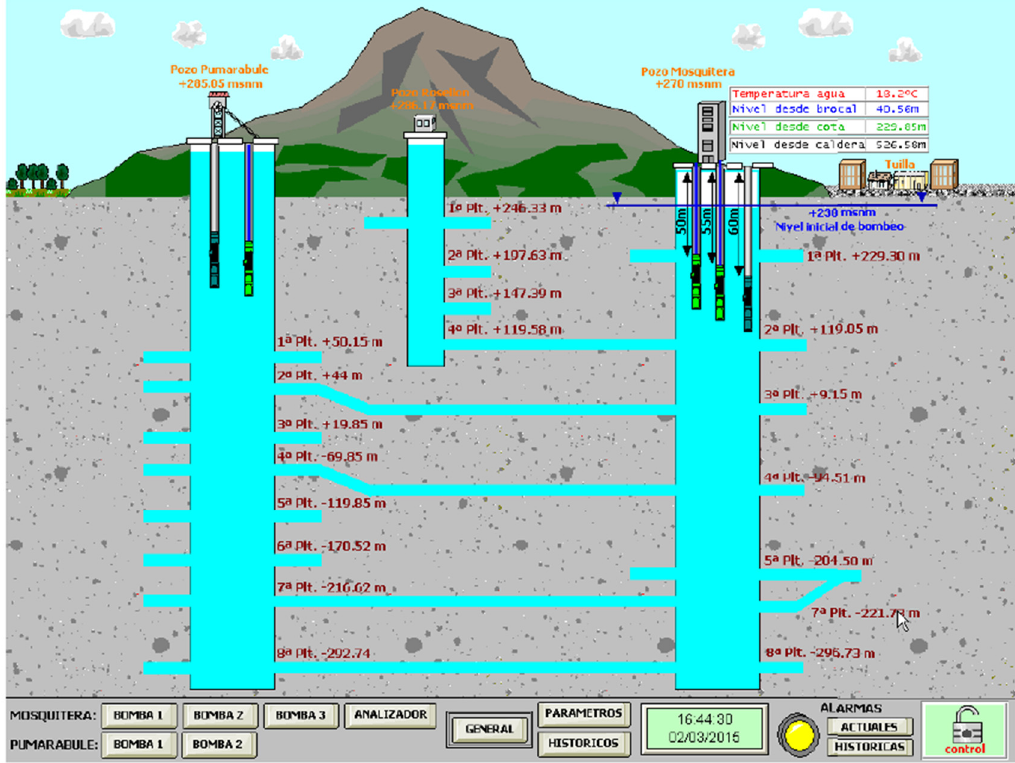
Figure 6. Pumping system installed in the Mosquitera and Pumarabule mines (courtesy of HUNOSA).